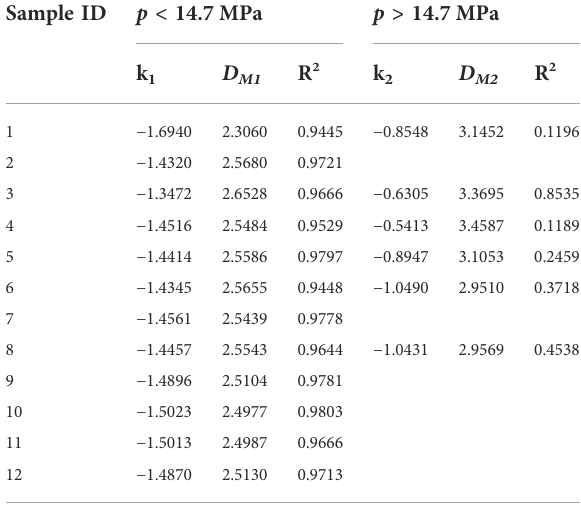
TABLE 2 Fractal dimension of mercury intrusion porosimetry (MIP) in shale samples. Sample